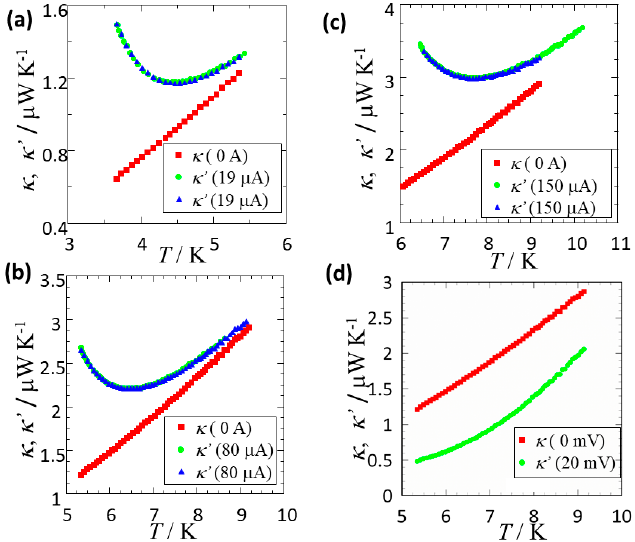
Figure 5. Temperature dependences of the experimentally determined κ (red square) and κ ’ (green circle) for ( a ) I = 19 , ( b ) I = 80 , ( c ) I =150 μ A, and ( d ) V = 20 mV. The blue circles show the calculated values from κ and P sample obtained by the resistivity value of the sample and applied currents. Since the charge disproportionation and fluctuations affect the structure of low-energy phonons through the electron-lattice coupling, the low-temperature heat capacity changes drastically depending on the ground states of the charge degrees of freedom [20,28]. A peculiar feature was observed in the heat capacity of θ -(BEDT-TTF) 2 CsZn(SCN) 4 by Yoshimoto et al. in the normal condition [20]. The temperature dependence of the lattice heat capacity divided by T 3 shows a large Boson peak structure around 2–3 K, which is a typical feature of molecular glasses and amorphous compounds [20,28,29]. On the other hand, such a peak structure is absent in the charge-ordered (CO) state of slowly cooled θ -(BEDT-TTF) 2 RbZn(SCN) 4 and metallic θ -(BEDT-TTF) 2 I 3 . This feature is consistent with the glass-like thermal conductivities of θ -(BEDT-TTF) 2 CsZn(SCN) 4 and rapidly cooled θ -(BEDT-TTF) 2 RbZn(SCN) 4 reported recently [30]. The Boson peak structure for the present sample was also detected by the heat capacity measurement in the normal state as shown in Figure 6a.